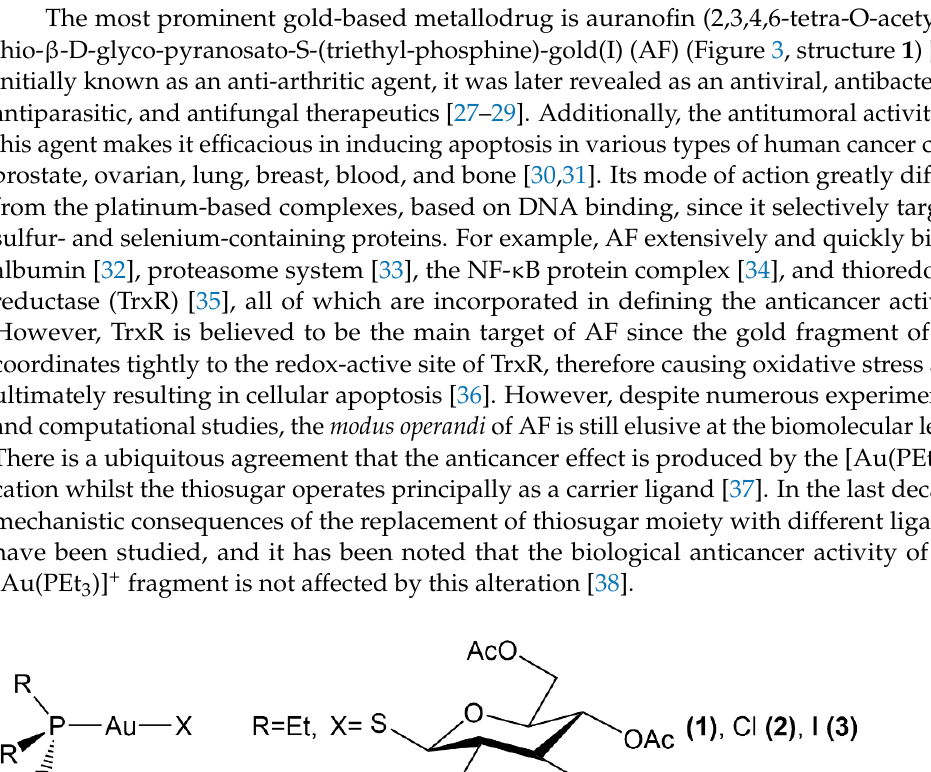
Figure 3 . Au(I)-based structures, ( 1 ) auranofin, ( 2 ) Et 3 PAuCl, ( 3 ) auranofin iodide, and ( 4 ) auranofin with phenyl substituents.